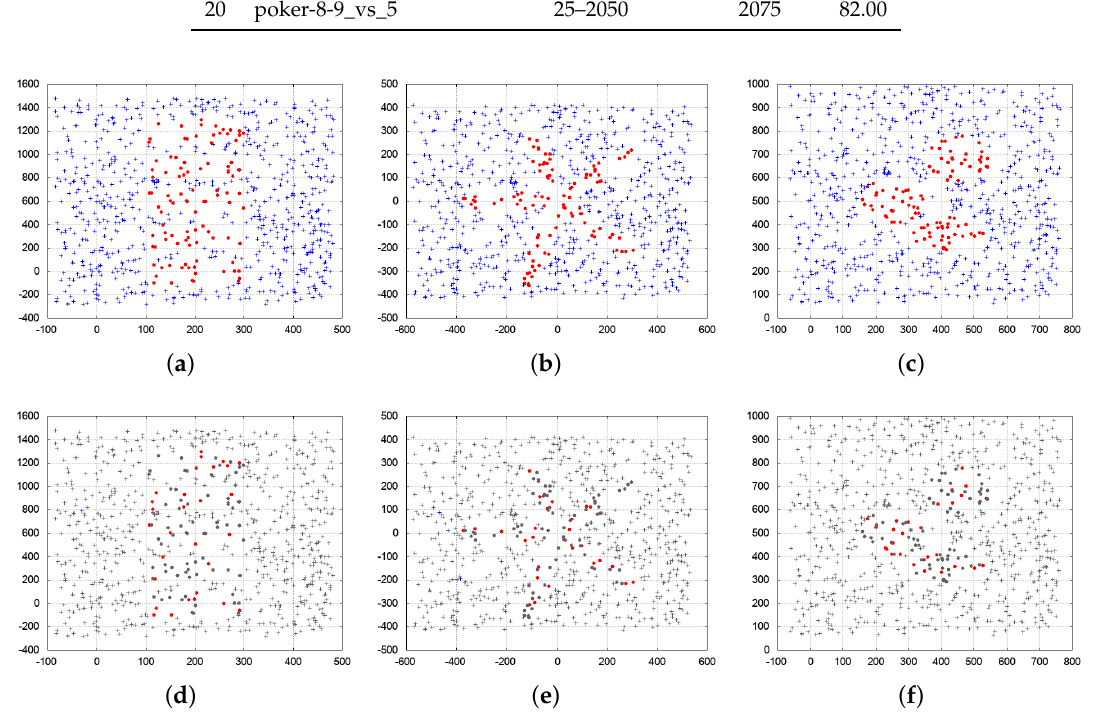
Figure 2. Scatter plots of the synthetic data sets with 0% and 70% of noise (points in gray color are for noisy data). ( a ) subclus-0; ( b ) clover-0; ( c ) paw-0; ( d ) subclus-70; ( e ) clover-70; ( f )